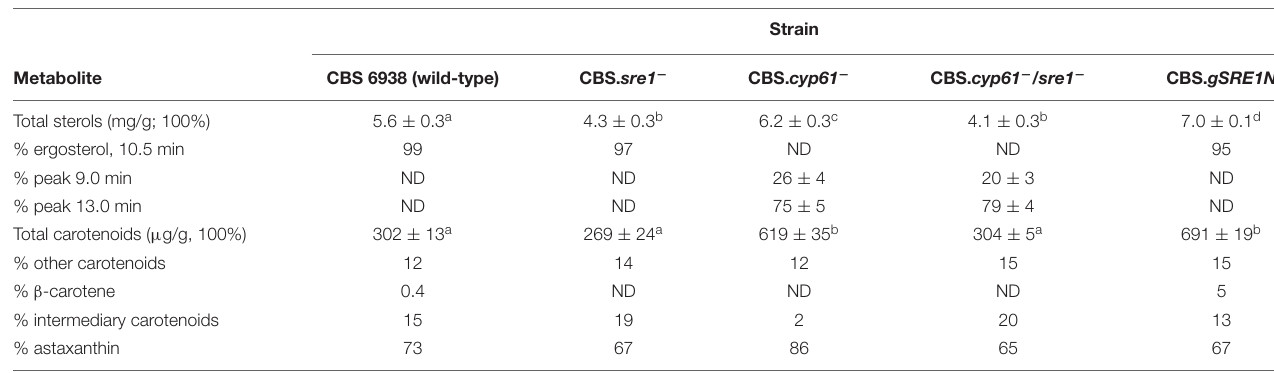
TABLE 2 | Sterol and carotenoid production in X. dendrorhous strains studied in this work.